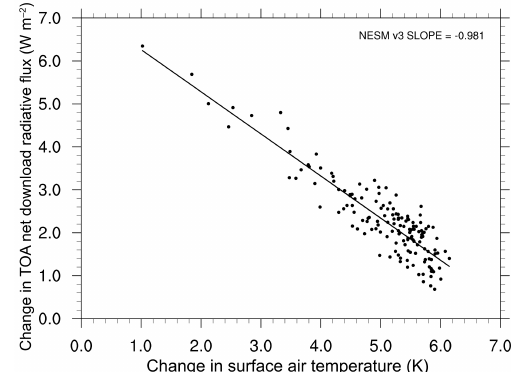
Figure 15. Results from the abrupt quadrupling of CO 2 experiment. The relationships between the change in the net TOA radiative flux and the global mean surface air temperature in NESM v3. The solid line represents a linear least squares regression fit to the 150 years of model output data. The interception at δT = 0 indicates the adjusted radiative forcing ( F = 7 . 24Wm − 2 ). The slope of the regression line measures the strength of the feedbacks in the climate system, which is the climate feedback parameter ( − 0 . 981Wm − 2 K − 1 ). The interception at the x axis gives the equilibrium δT